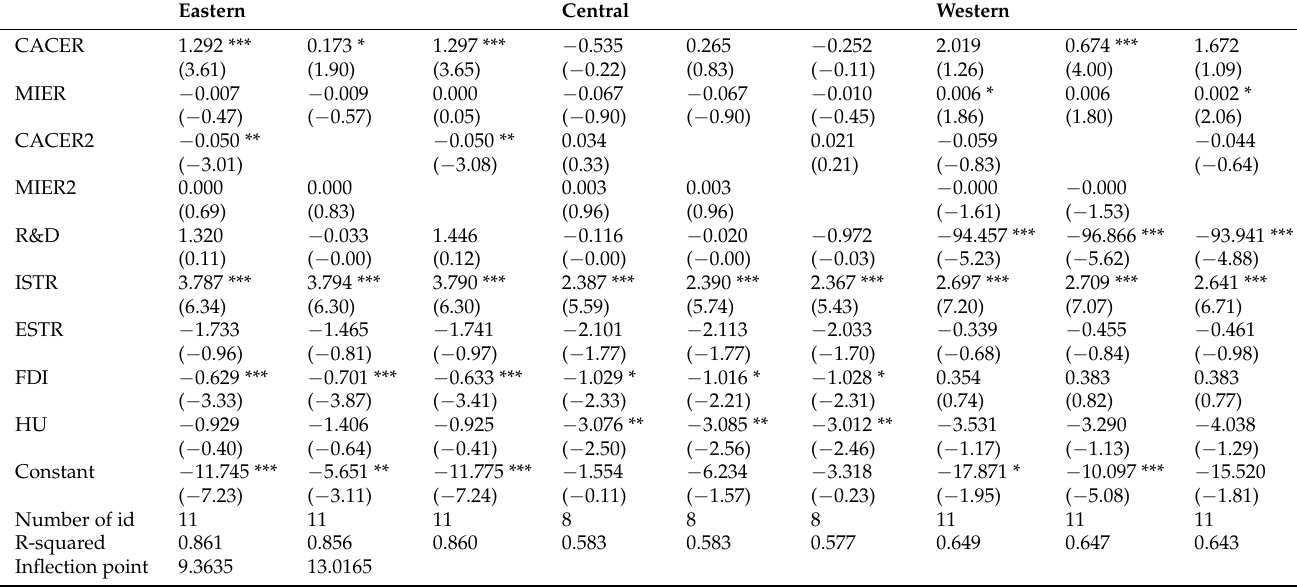
Table A4. The estimated results of the impacts of ERs on OFDI across regions (FE